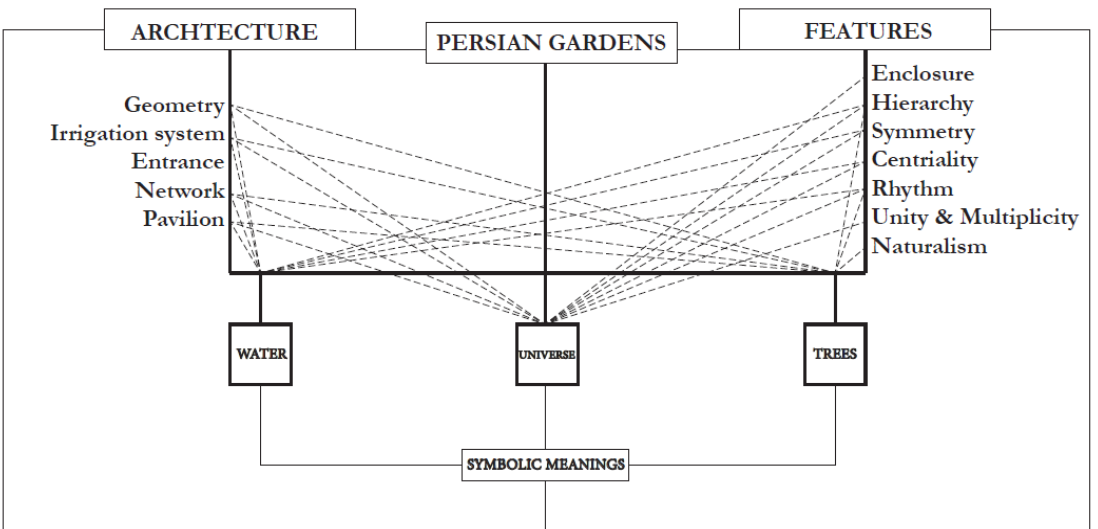
Figure 21. Relationship between symbolic meanings and Persian gardens features and architecture. Source: Own